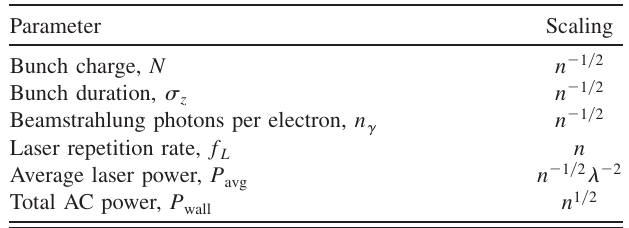
TABLE II. Plasma density and laser wavelength scalings in the regime not limited by beamstrahlung ( N ¼ N Parameter Scaling